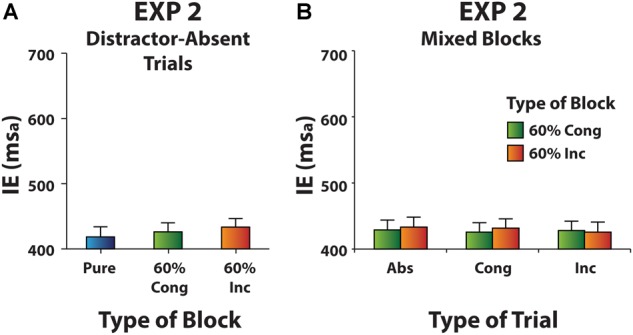
(A) Experiment 2: Mean IE scores for distractor-absent trials in Pure and Mixed blocks. (B) Experiment 2: Mean IE scores in Mixed blocks as a function of Type of Trial (distractor-absent, congruent distractor, and incongruent distractor), separately for 60% Cong block and 60% Inc block data. Error bars represent the standard error of the means across participants.